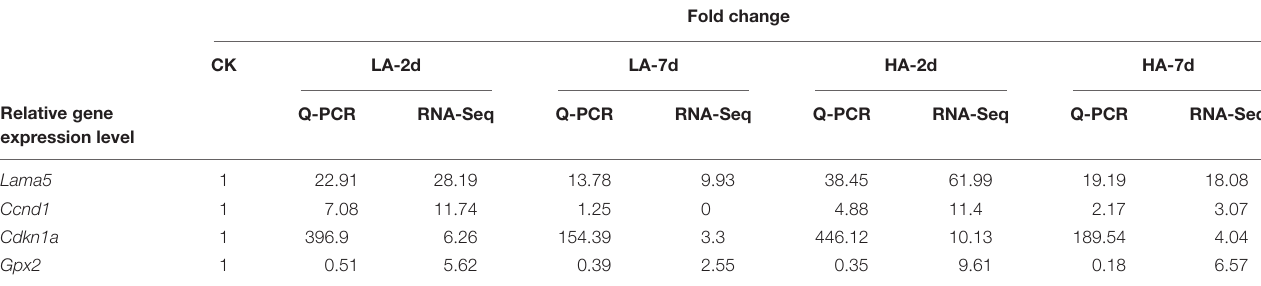
TABLE 6 | Summary of Q-PCR results and RAN-Seq results for randomly selected genes.